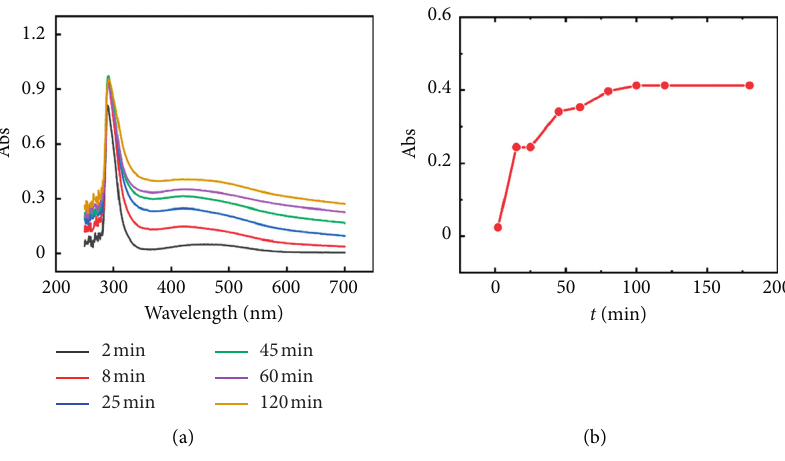
Figure 3: (a) The UV-vis spectra of DA solutions. (b) Absorption intensity in 350nm during the reaction process. Table 1: Effect of MWNTs concentration on morphology of capsules during the reaction. The scales bar in photos is 2 mm. Time